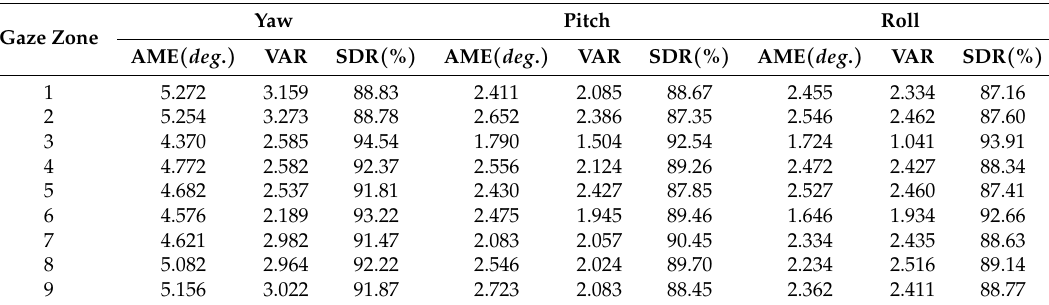
Figure 10. Comparisons of GT (Ground-truth) and predicted head pose value on ( a ) yaw, ( b ) pitch, and ( c ) roll. Table 2. Statistical Results for Head Pose